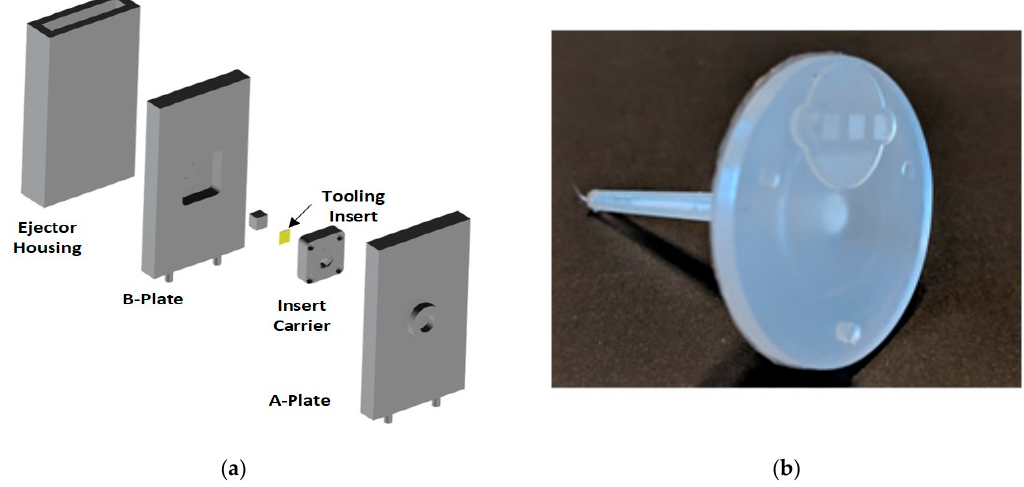
Figure 3. ( a ) Exploded view of the mold base shows the assembly of the 3D printed tooling insert in the steel mold and ( b ) plastic part injection molded using the 3D printed tooling insert and replicated microfeatures.